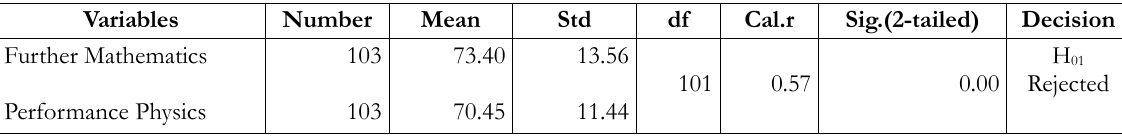
Table 2. PPMC of the Prediction between Further Mathematics and Physics